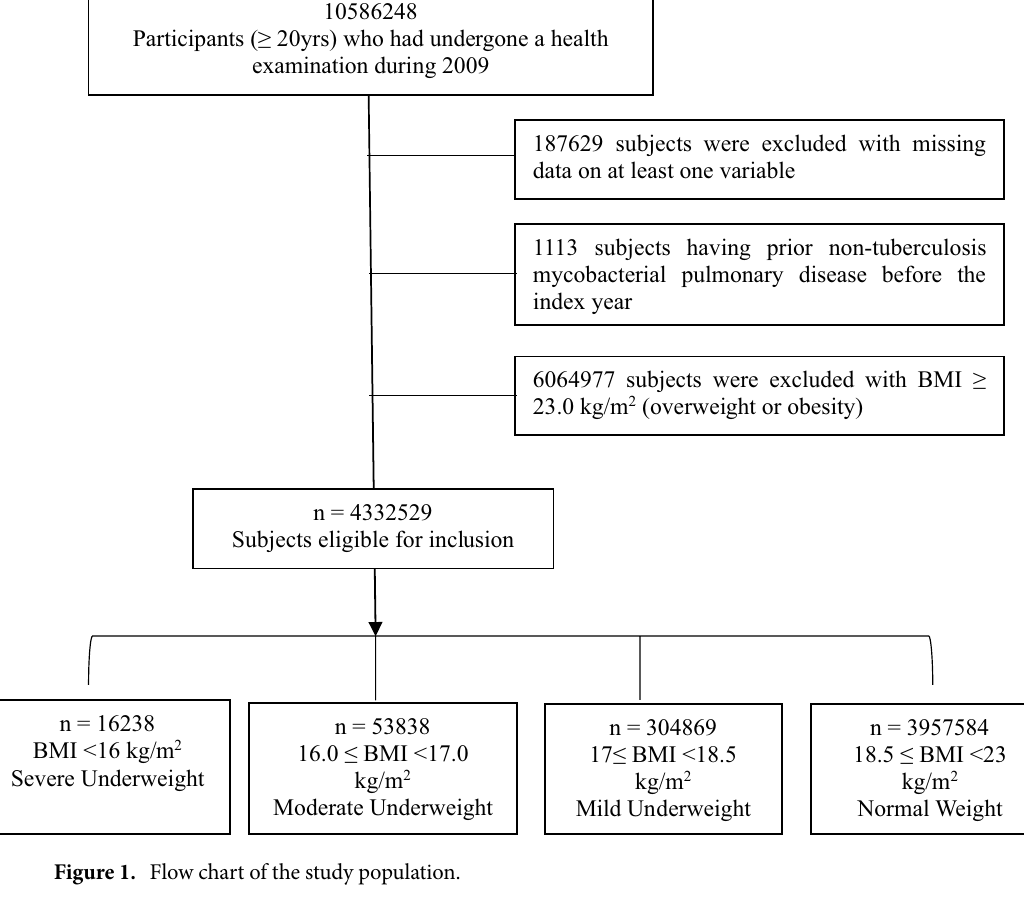
Figure 1. Flow chart of the study